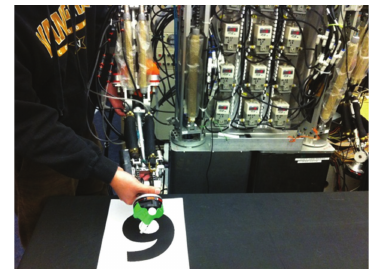
Figure 12: Demonstrations.